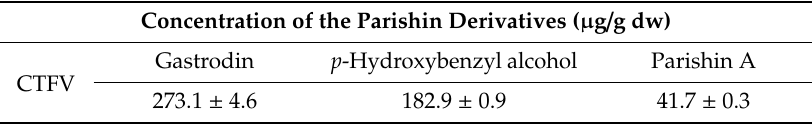
Table 2. The parishin derivatives of